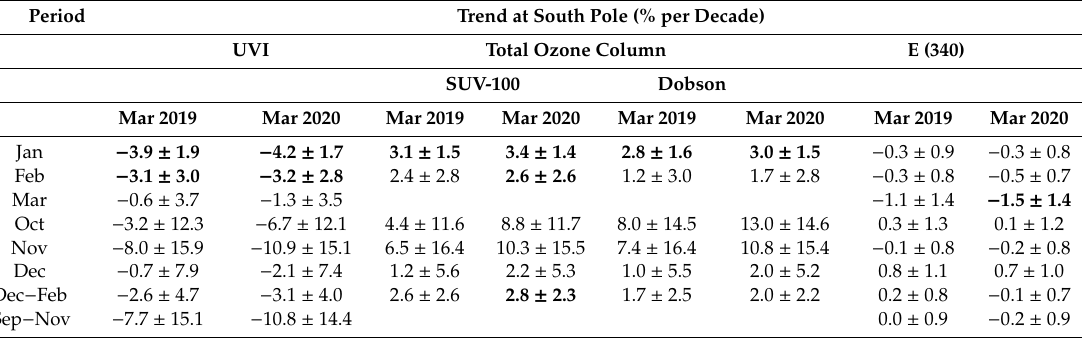
Table 4. Trends in UVI, TOC, and E(340) at the South Pole calculated either for the period January 1996–March 2019 (columns “Mar 2019”) as in the work by McKenzie et al. [14] or for the period January 1996–March 2020 (columns “Mar 2020”), which includes the period of the small ozone hole in the spring of 2019. UVI and E(340) trends were corrected with Method 3. Uncertainties of trends are provided at the 95% level. Trends that are statistically significant are indicated in bold face.